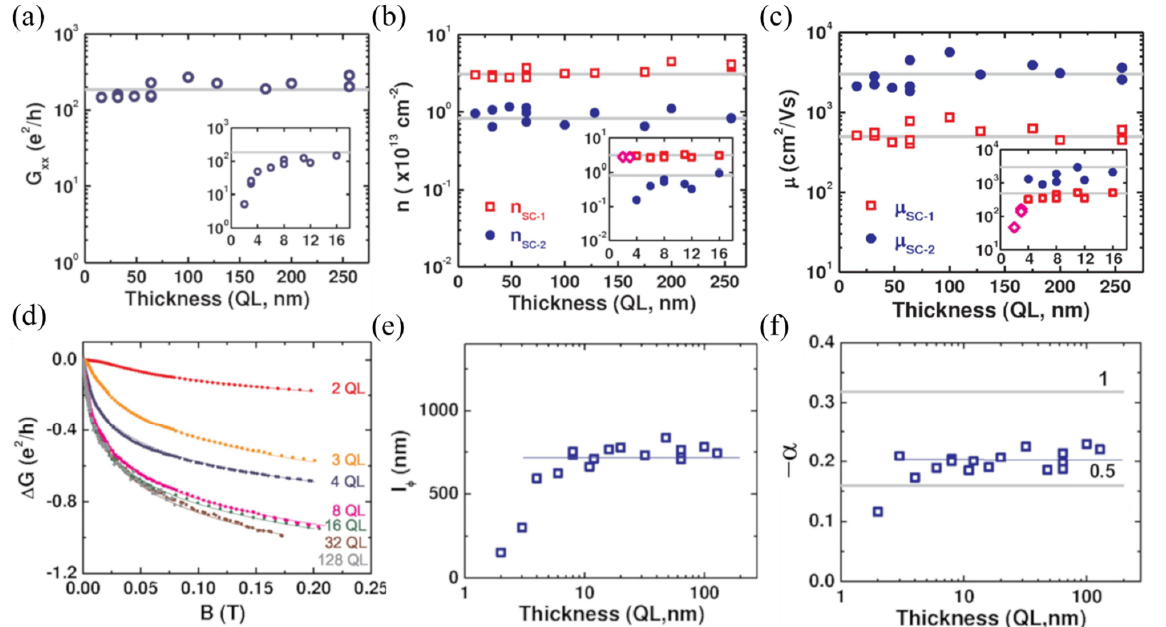
Figure 7. Transport data of Bi 2 Se 3 thin films against thickness: ( a ) conductance, ( b ) carrier density, ( c ) mobility. The solid straight lines are guides for the eyes. The subscript SC 1 corresponds to the topological surface states whereas the subscript SC 2 corresponds to the 2DEG. ( d ) Magnetoconductance for different thicknesses. ( e ) l ϕ against thickness. ( f ) α against thickness. Insets in ( a ), ( b ), and ( c ) show the data for thinner films. Reprinted with permission from Reference [64]. Copyright 2012 American Physical Society.